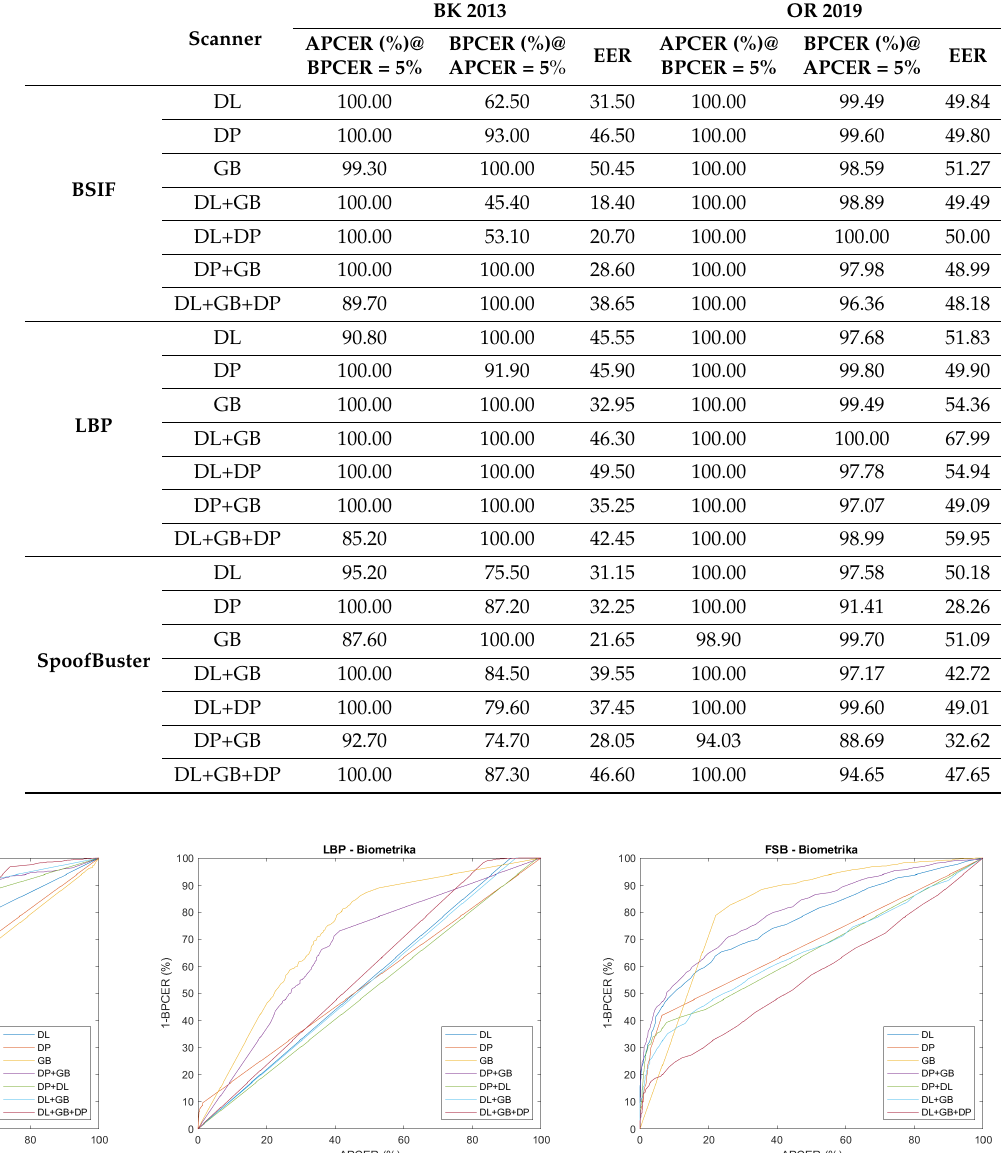
Table 11. Results in terms of accuracy, BPCER, and APCER at different operational points of BSIF, LBP, and SpoofBuster PADs with different single-sensor and multi-sensor training techniques for earlier LivDet editions datasets.